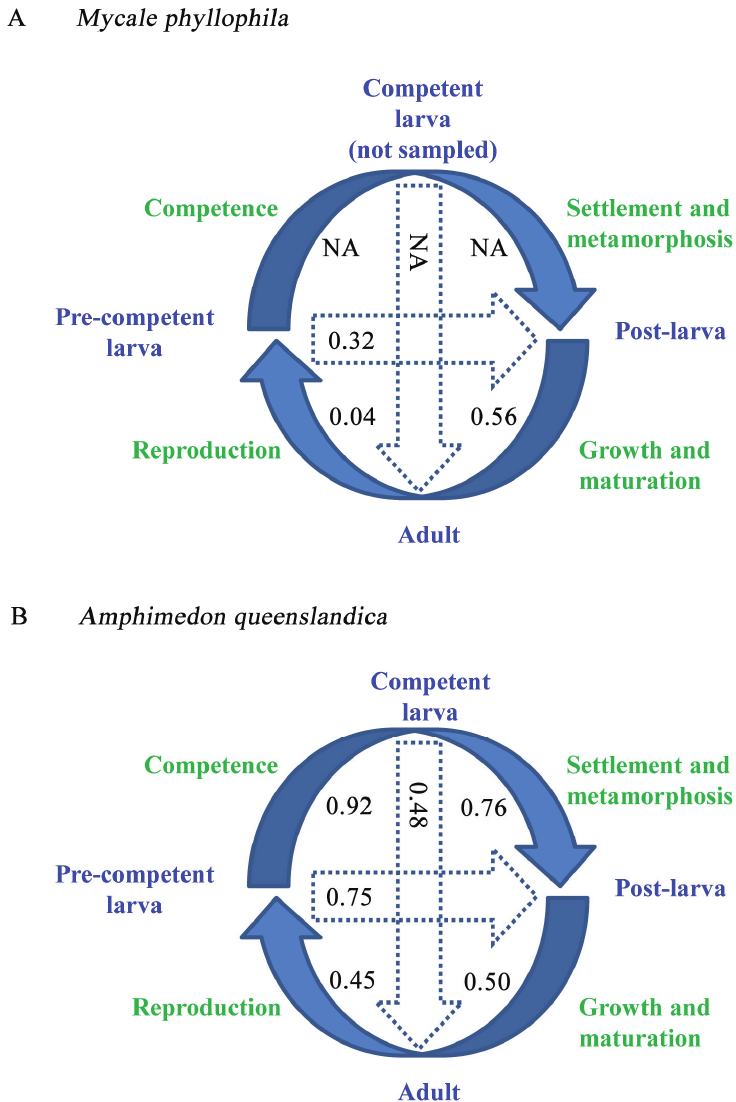
Figure 10. Comparing the life cycle transcriptome profiles of M. phyllophila ( A ) and A. queenslandica ( B ). Solid and broken arrows connect life cycle stages that are consecutive and non-consecutive, respectively. Pearson’s r s for the first gene expression analyses are presented for the two species next to their connections. The r s for M. phyllophila are from Figure 5A, whereas those for A. queenslandica are from Conaco et al. ([30]: Figure 4A). (NA) = not available, as a sample of the competent larva stage remains unavailable for M. phyllophila